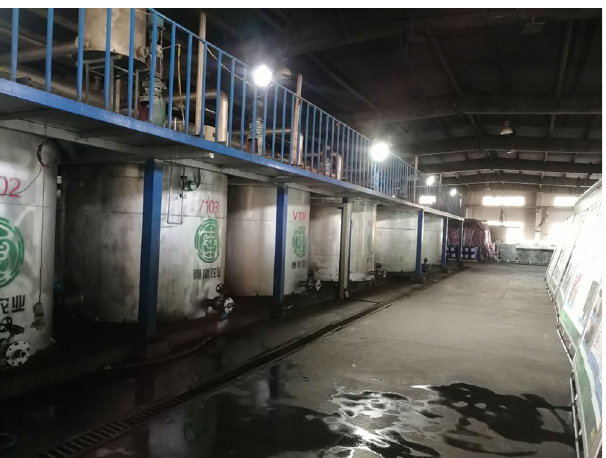
Figure 2. The reactors of the modified Fenton reaction equipment at the experimental site of Tongchuan, Shannxi,